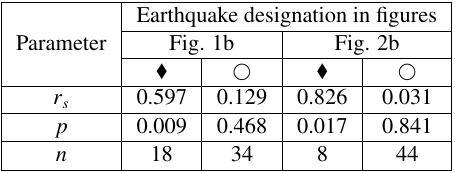
Table 2. Estimates of correlation Spearman coe ffi cient r s and its significance level p between earthquake energy class K s and distance from a hypocenter D to Karymshina site for each group of the detected earthquakes, n is the number of earthquakes in a group. Symbols ( (cid:7) ) and ( (cid:13) ) are the same as for Table 1. Fig. 1b Fig. 2b